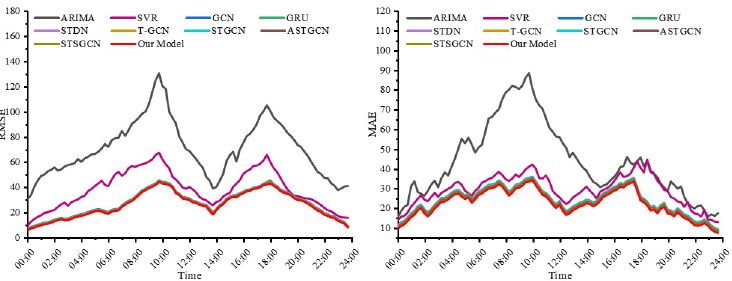
Fig 10. Performance comparison of models for different time periods on the Xinglin interchange